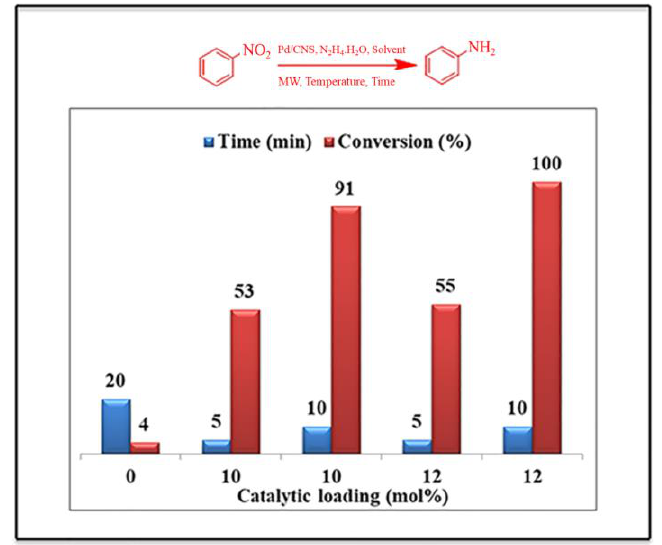
Figure 9. The reaction conditions during the optimization of the reduction reaction of nitrobenzene in ethanol with different catalytic loadings and varying times. Adapted with permission from ref. [30].